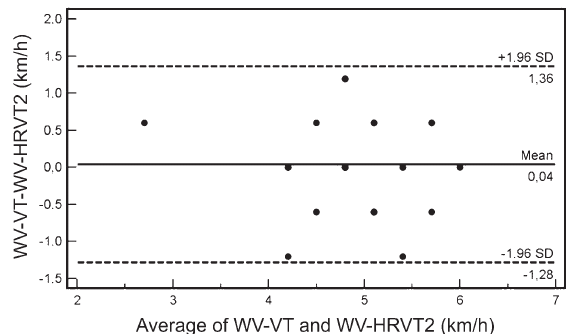
Table 1. General characteristics of the individuals studied.